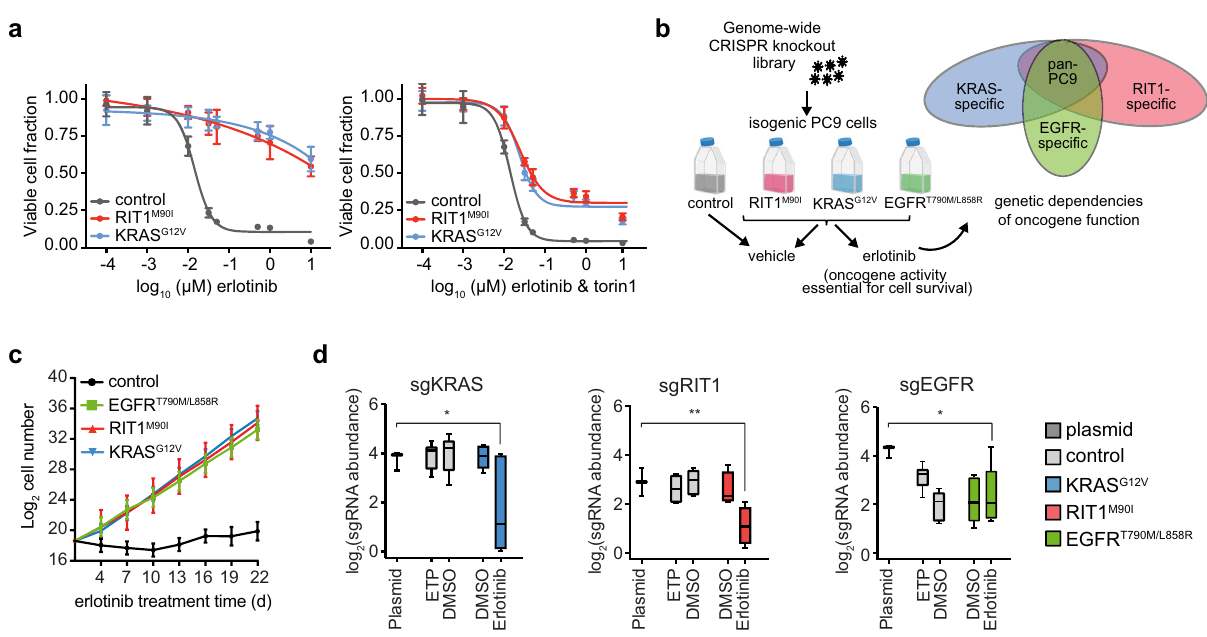
Fig. 2 Building an integrative oncogene-dependency map of EGFR T790M/L858R , KRAS G12V , and RIT1 M90I . a 96-hour dose – response of isogenic PC9 cells to erlotinib alone (left panel) or to a 1:1 molar ratio of erlotinib and torin1 (right panel). Fraction of viable cells was determined using CellTiterGlo and normalized to the average value in DMSO treated cells. Data shown are the mean ± s.d. of 8 technical replicates. b Schematic of the genome-wide CRISPR- Cas9 screens performed in isogenic PC9 cells. Created with BioRender.com. c , Proliferation rates of the PC9-Cas9 isogenic cells used for genome-wide screening in 50 nM erlotinib. Data shown are the mean ± 95% con fi dence interval for two replicates per cell line. d Box plot showing sgRNA abundance (log 2 reads per million) of sgRNAs targeting each indicated gene. Abundance in the plasmid library, early time point (ETP), or after 12 population doublings in vehicle (DMSO) or erlotinib was determined by PCR and Illumina sequencing. Box plots show the median (center line), fi rst and third quartiles (box edges), and the min and max range (whiskers) of replicates. * p = 0.022 (sgKRAS), ** p = 0.009 (sgRIT1), * p = 0.004 (sgEGFR) calculated by one-sided permutation testing using MAGeCK. For control PC9 cells ETP and DMSO, n = 3 biological replicates. For oncogene-expressing PC9 cells DMSO